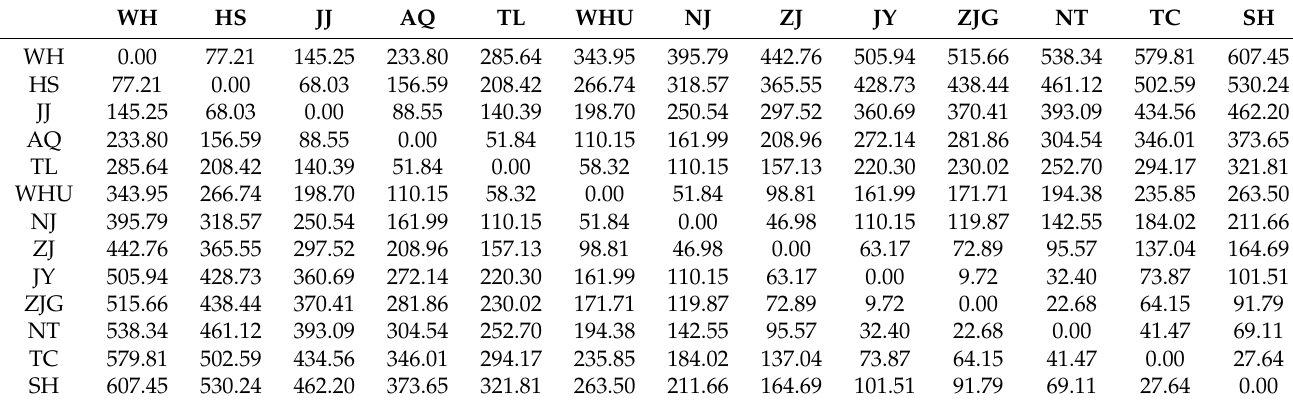
Table 6. Distances between ports (nautical